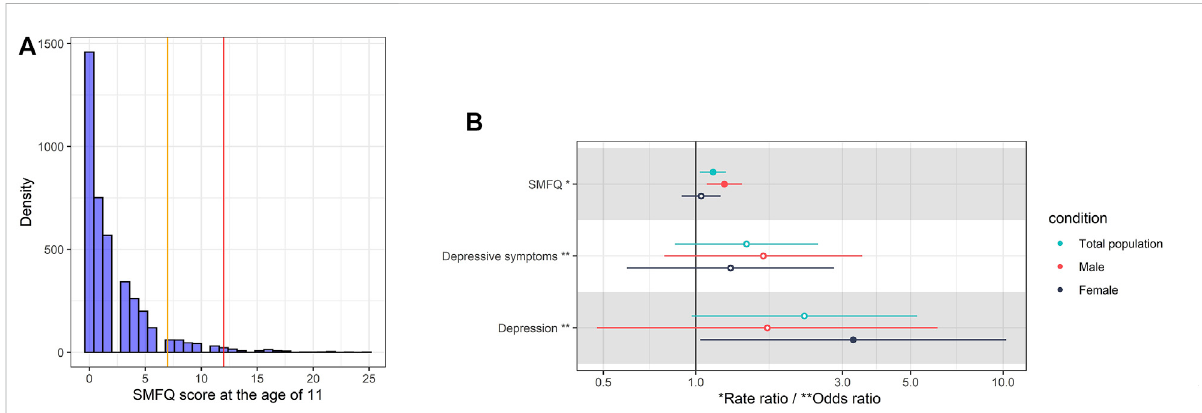
FIGURE 2 (A) Histogram of SMFQ score at 11 years. The vertical orange and red lines are the cut-offs of depressive symptoms (SMFQ > 7) and depression (SMFQ > 11), respectively. (B) Rate ratio per standard deviation (95% CI) of obesity at 7 years (exposure variable) for SMFQ score (outcome), and odds ratio of obesity at 7 years (exposure variable) for depressive symptoms (SMFQ > 7) (outcome), and depression (SMFQ > 11) at 11 years (outcome). The model is adjusted for sex and age, physical activity at age 5, mother ’ s age at birth, birthweight, mother ’ s pre-pregnancy BMI, average